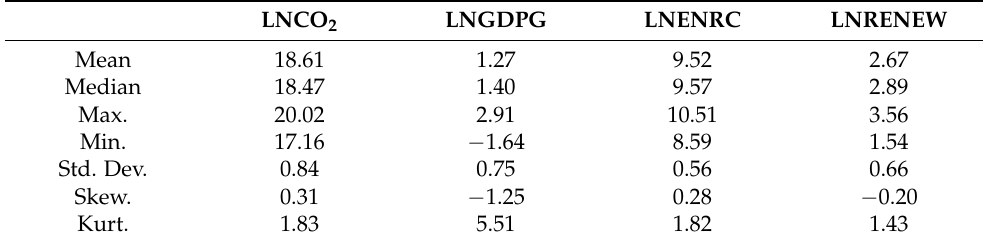
Table 2. Results of Descriptive Statistics.